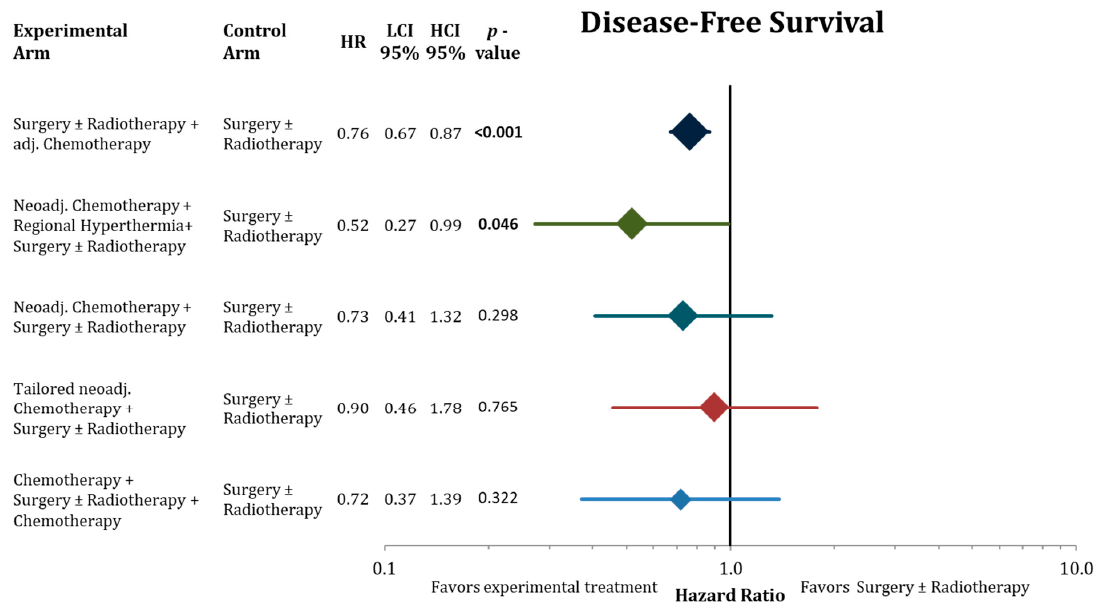
Figure 4. Forest plot comparing disease-free survival in the network analysis of the experimental treatments against surgery ± radiation therapy. Hazard ratios with 95% confidence intervals and the corresponding p -values are presented. The sizes of the diamonds are proportional to the weights in the meta-analysis. HR = hazard ratio, LCI = lower limit of 95% confidence interval, and HCI = higher limit of 95% confidence interval. Bold values indicate significant p